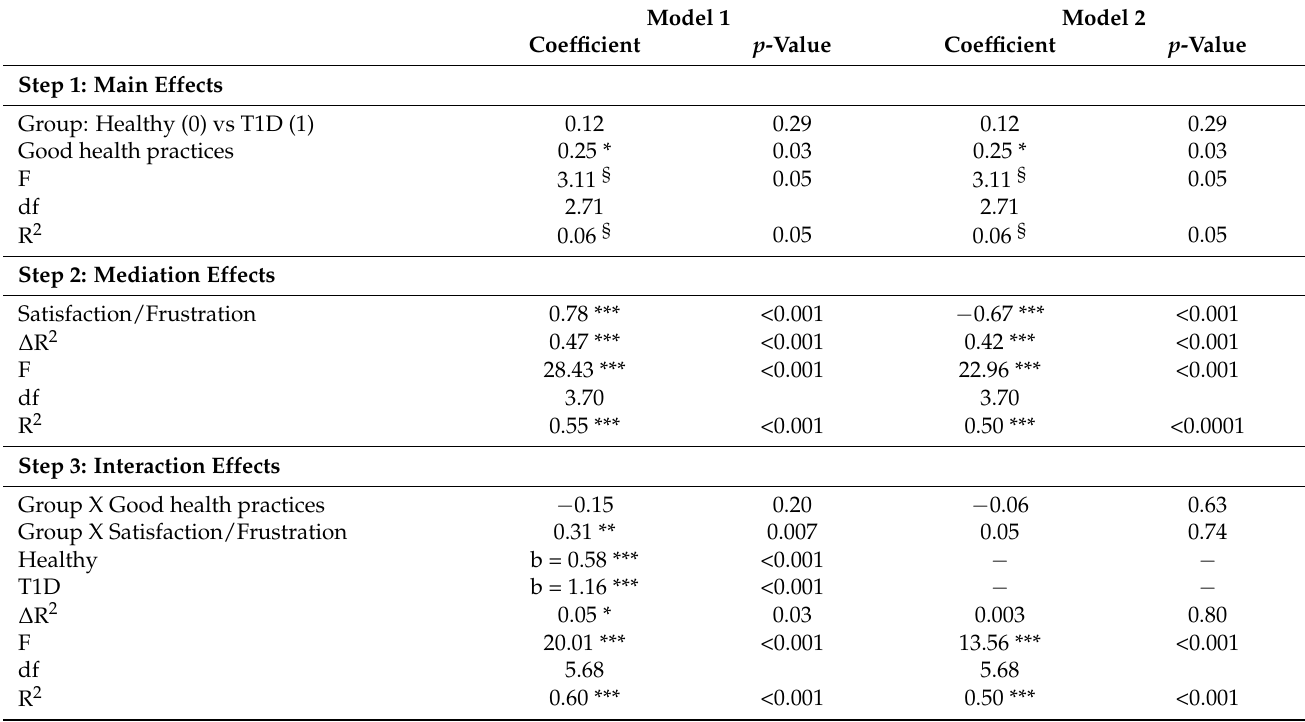
Table 7. Hierarchical regression models for the dependent variable psychological